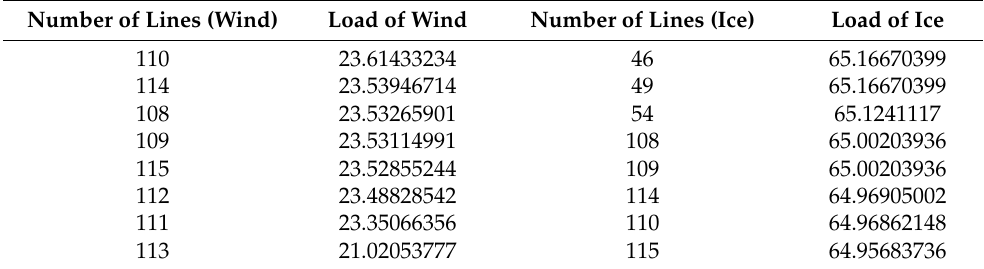
Table 5. Load of wind and ice of highest 8 lines in IEEE-118 during this process.